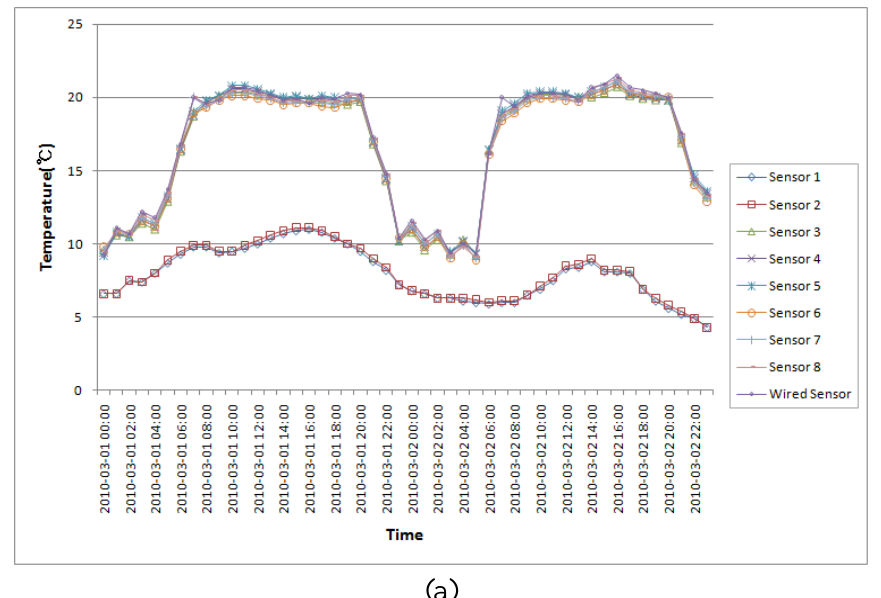
Figure 19. Temperature and Humidity Variation Graph of Hog Farm A. (a) Temperature Variation Graph of Hog Farm A (2010/03/02); (b) Humidity Variation Graph of Hog Farm A